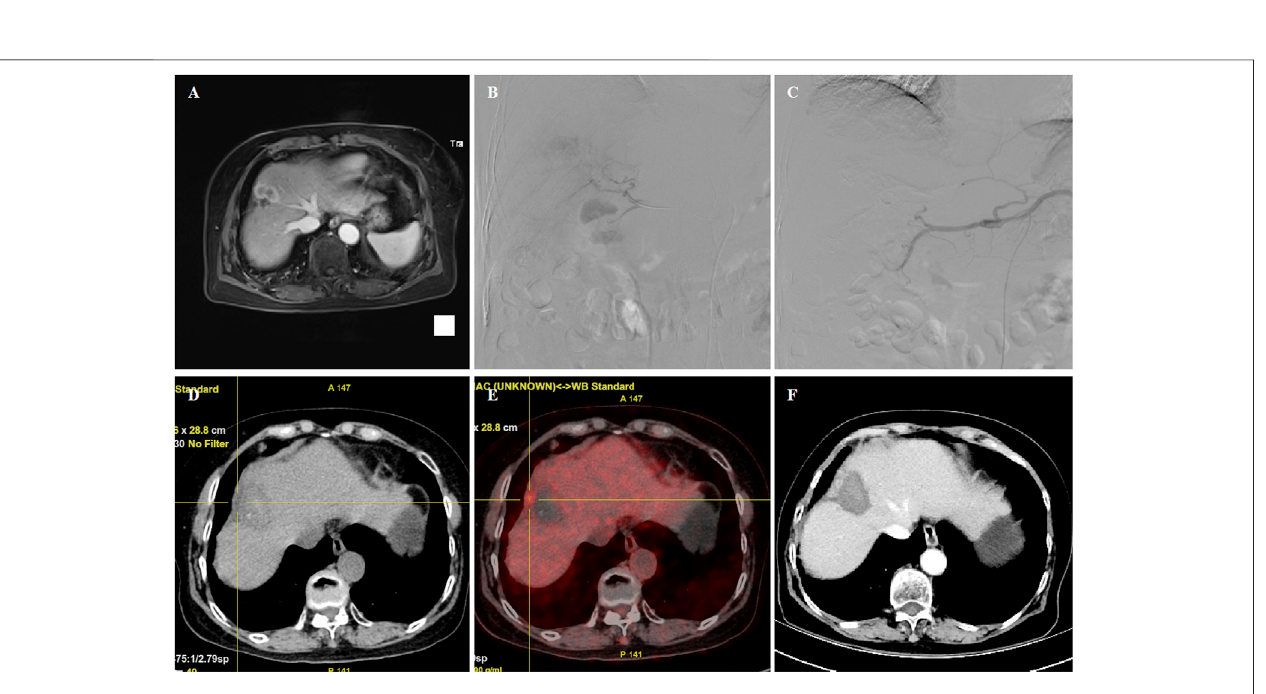
FIGURE 3 | 70 years female patient treated with CalliSpheres beads for advanced primary HCC. (A) MR revealed HCC in the right lobe. (B – C) Tumor staining was shown, and the right hepatic artery was embolized by 100 – 300 μ m oxaliplatin-loaded beads. (D – E) PET-CT revealed a shrunk tumor with a small residual